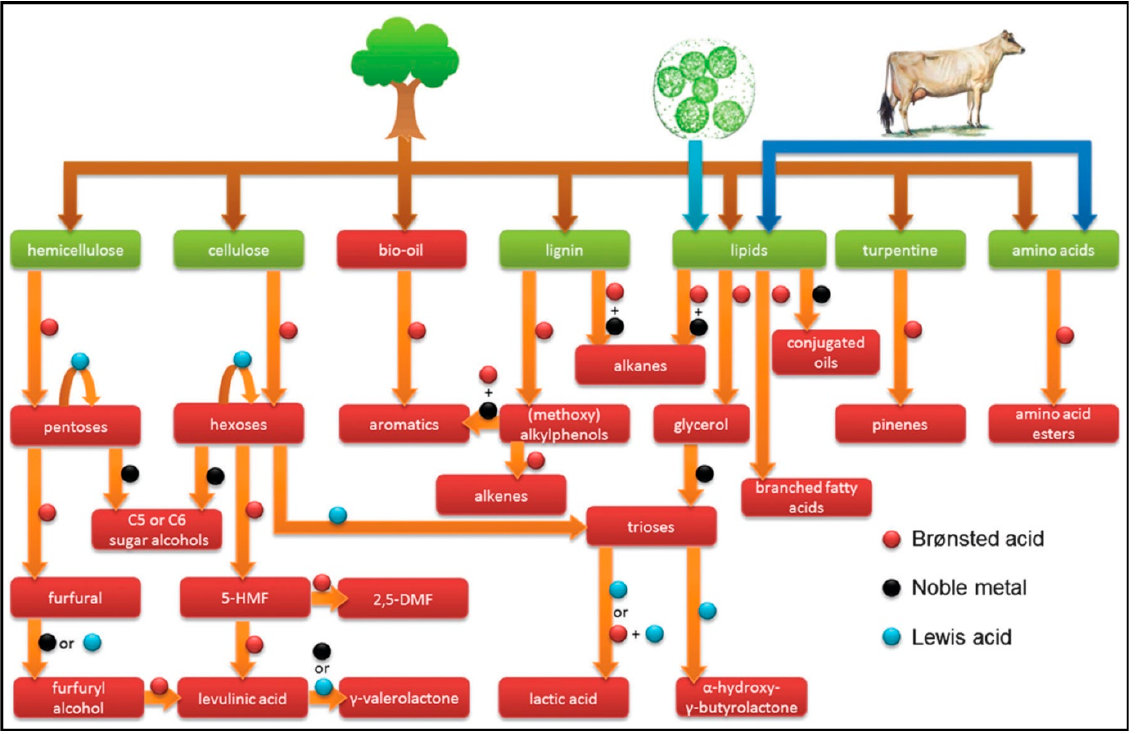
Figure 2. A comprehensive summary of the various biomass conversions and the corresponding catalytic active sites employing zeolites [10] (Open Access). catalytic active sites employing zeolites [10] (Open